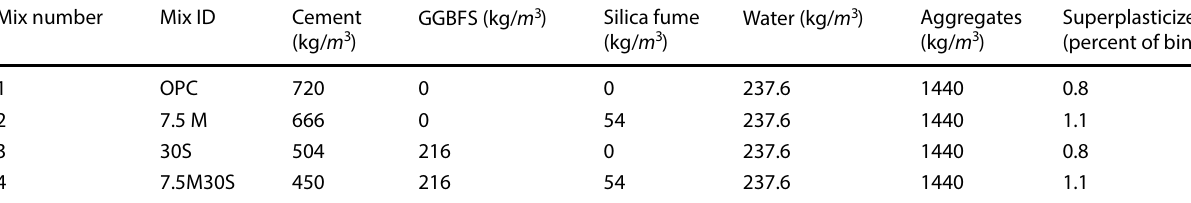
Table 6 Mix proportion of Portland cement-based concretes Mix number